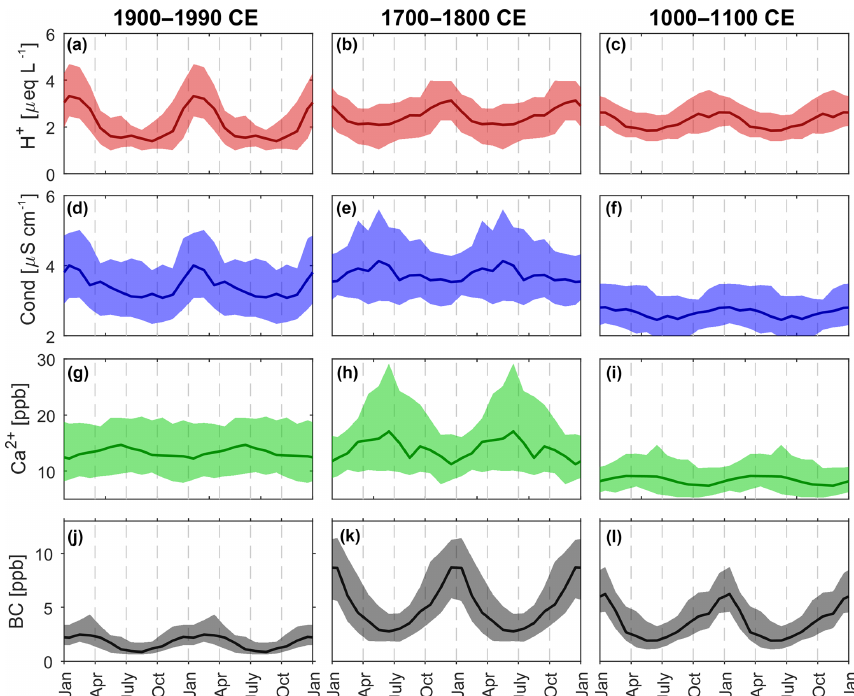
Figure 8. Average annual signals of two successive years in (a–c) acidity (H + ), (d–f) conductivity (Cond), (g–i) calcium (Ca 2 + ), and (j–l) black carbon (BC) during three selected centuries, calculated under the assumption of constant snowfall through the year. The main RICE CFA data only extend to 1990CE. The line shows the monthly averaged median value of measured concentrations, and the colored area signifies the 50% quantile envelope of the value